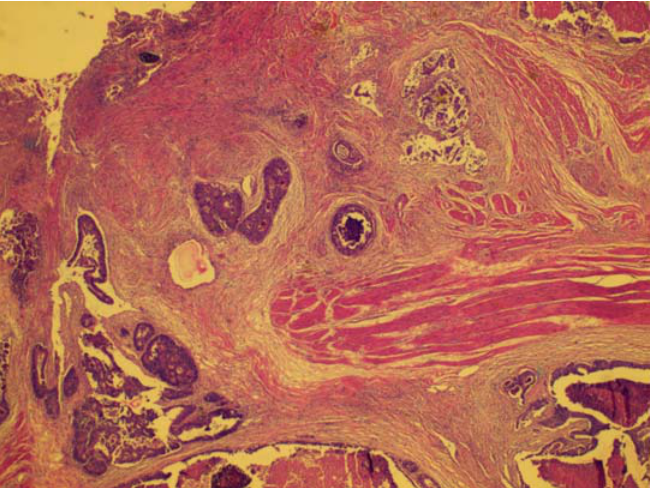
Figure 1. A rectal wall with ulcerated mucosa (top) and tumor islands infiltrating into the muscular propria layer. Table 2. Specificity and sensitivity, EUS_T and EUS-RTE_T.